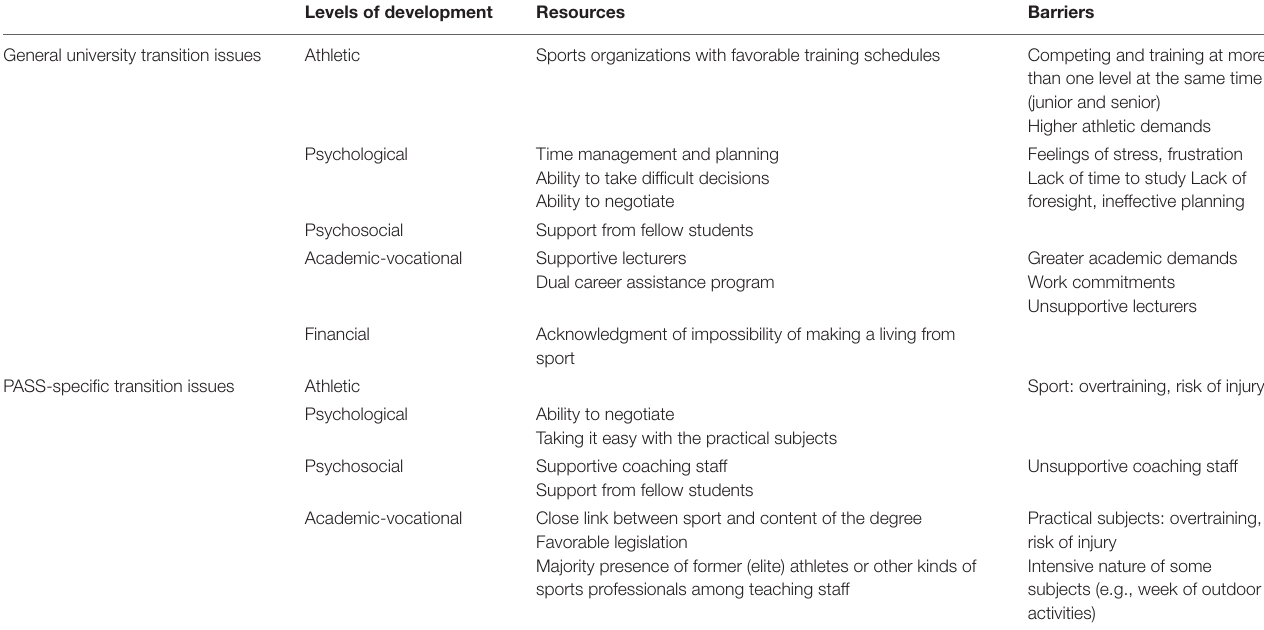
TABLE 2 | Main resources and barriers